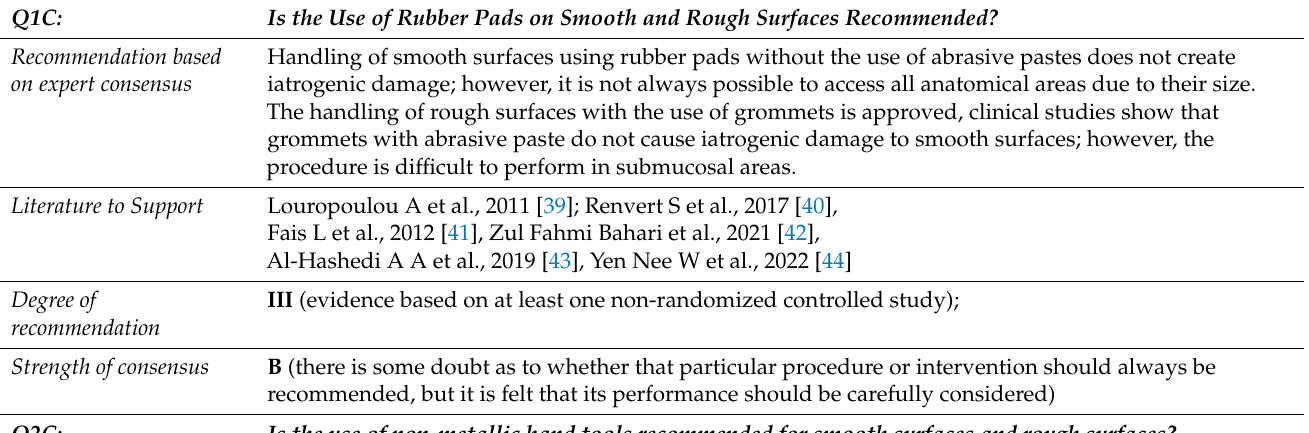
Table 4. Recommendations for the management of implant